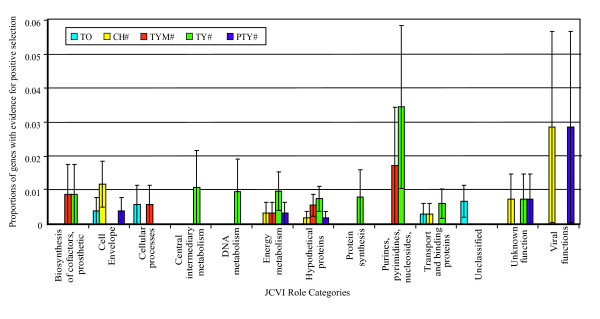
Proportions of genes with evidence of positive selection among individual JCVI role categories. Only genes that showed no evidence for recombination were used to generate the data showed here. Bars indicate estimated standard error for the proportion of genes with evidence of positive selection in each role category; standard errors were calculated as the square root of p (1-p)/n, where p is the frequency of genes with evidence of positive selection in a given role category, and n is the total number of genes in a given role category. Among the 20 JCVI role categories, seven did not include genes with evidence of positive selection and are thus not included in this figure. For each role category, proportion of genes with evidence of positive selection in the overall test (TO) and each of the four branch specific tests (Ch# = Choleraesuis branch specific test; Ty# = Typhi branch specific test; Tym# = Typhimurium branch specific test; Pty# = Paratyphi A branch specific test) are shown.